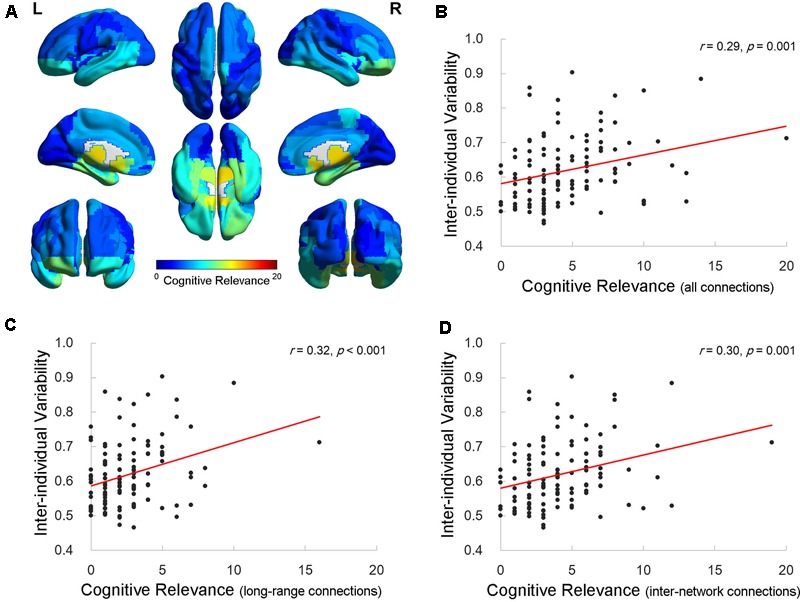
Relationship between inter-individual variability and the cognitive relevance of functional connectivity. (A) The cognitive relevance map of AAL cerebral regions. Each AAL regions of interest (ROI) was color coded as the total number of connections that are correlated with four specific cognitive domains. (B–D) The scatter plots show the correlation between the inter-individual variability and cognitive relevance as indexed by the total number of cognition-related connections (B), long-range connections (C), and inter-network connections (D) across 116 AAL ROIs, respectively. Each dot represents one ROI from AAL.